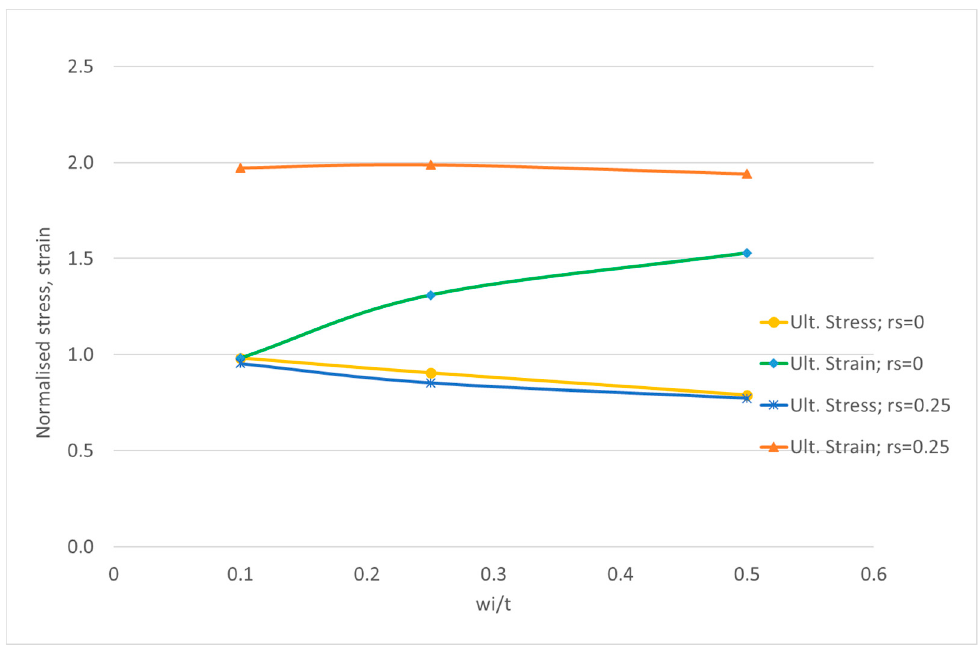
Figure 7. Variation of ultimate strength and corresponding normalized strain for plates with t = 20 mm, m = 3 and no residual stresses.